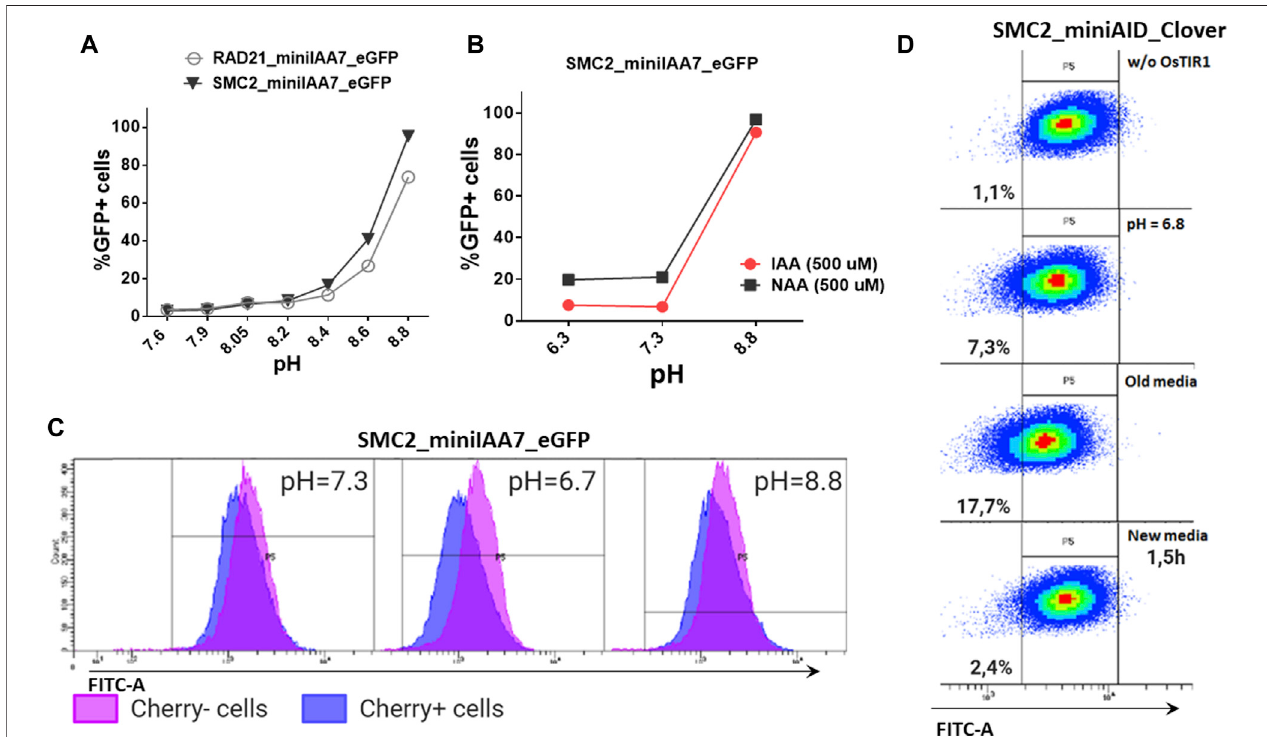
FIGURE 6 | Effects of pH on AtAFB2 and OsTIR1 AID degradation ef fi ciency. (A) High pH levels inhibit auxin-induced eGFP degradation in HAP1 clones with RAD21 and SMC2 modi fi cations. Experiments were performed in duplicate. (B) IAA and NAA auxin analogs show similar sensitivity to pH changes (HAP1 clones). Experiments were performed in duplicate. (C) eGFP levels in the mosaic HAP1 clone SMC2-miniIAA7-eGFP. Blue color indicates eGFP levels in Cherry pos subpopulation, and purple color indicates Cherry neg subpopulation. The shift between two peaks illustrates minor basal degradation induced by AtAFB2 in Cherry pos cells. (D) Shift of mES cell population (OsTIR1 system) toward left on the FITC-A axis in acidic